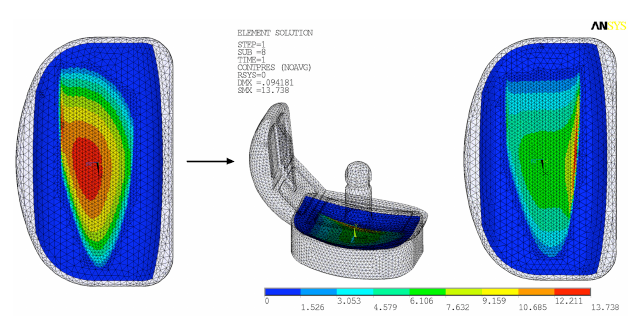
Fig.10 Result of optimization on a type with free PE insert in position 1